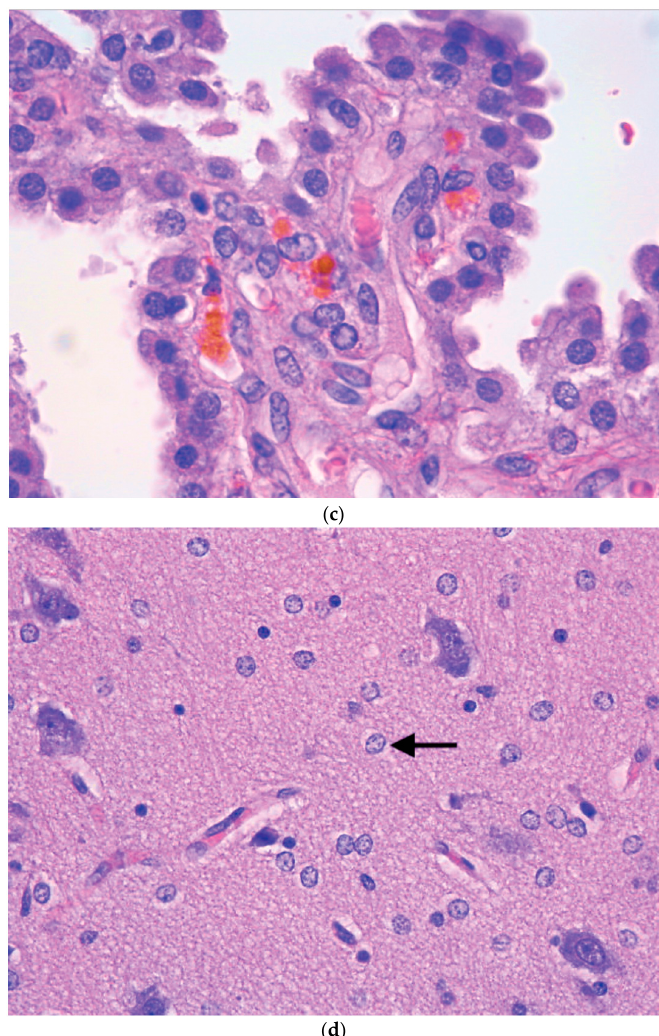
Figure 1. Neuropathologic findings from a patient with kernicterus. ( a ) Yellowish discoloration of subthalamic nucleus and hippocampus; ( b ) discoloration of medullary tegmentum, inferior olives, and cerebellar tonsils; ( c ) cytoplasmic pigment in cells of choroid plexus (20 × magnification); ( d ) Alzheimer’s type II astrocytes (arrow) in keeping with liver failure (20× magnification).